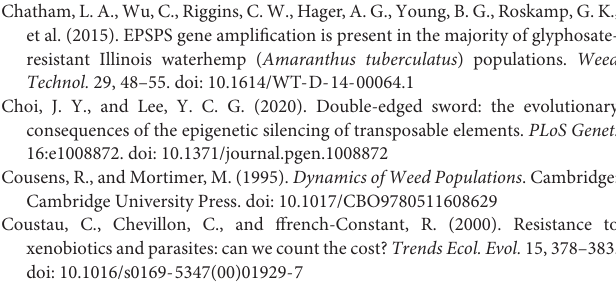
Supplementary Table 1 | Primer sequences for qPCR. Supplementary Table 2 | p values for LD 50 value student t -test comparison between each seed family. Bold text indicates a non-significant difference between seed families. Families are ordered left to right from most susceptible to most